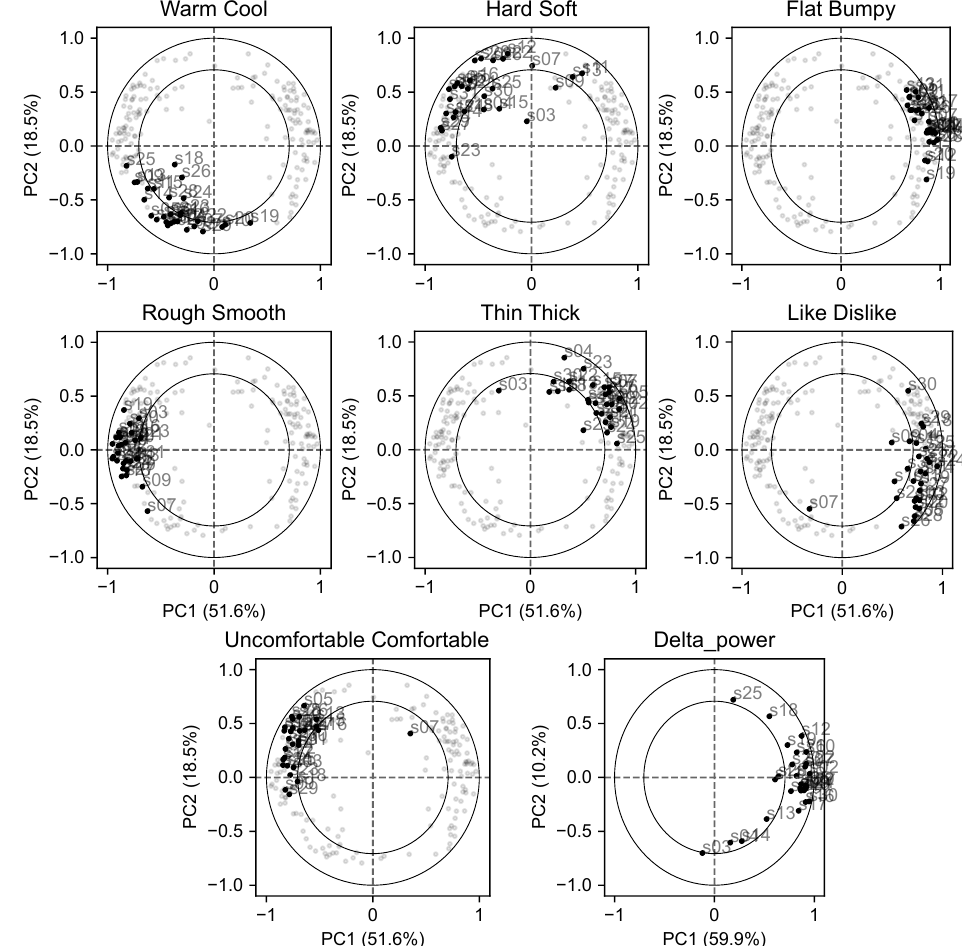
Figure 8. Consonance analysis (loadings)—sensory and delta power (horizontal unfolding) . Cor- relation loadings plot for each sensory attribute. Each graph represents the same data. The same graph is repeated highlighting each sensory attribute at a time. The level of agreement is given by the level of the clustering of the